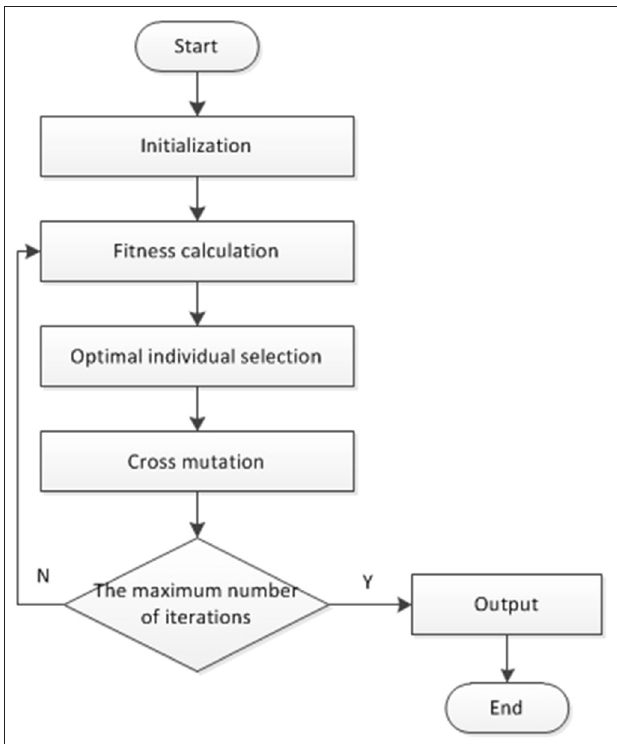
FIGURE 1 | Main process of genetic algorithm.